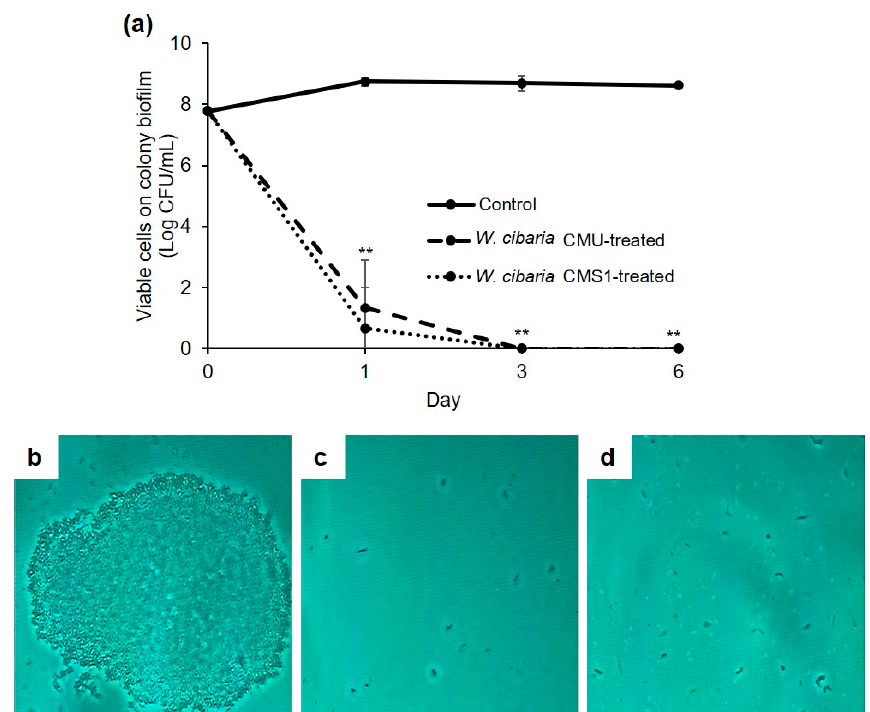
Figure 2. Effects of W. cibaria CMU and CMS1 on multi-species biofilm during co-culture at 1, 3, and 6 d measured using ( a ) viable cell counting and ( b – d ) phase-contrast microscopic analysis. ( a ) Number of viable cells in the colony biofilm over time. Significant differences as compared to control were determined as ** p ≤ 0.001. ( b ) Control, ( c ) W. cibaria CMU-treated, and ( d ) W. cibaria CMS1-treated observed on the sixth day. Magnification, 4000 ×